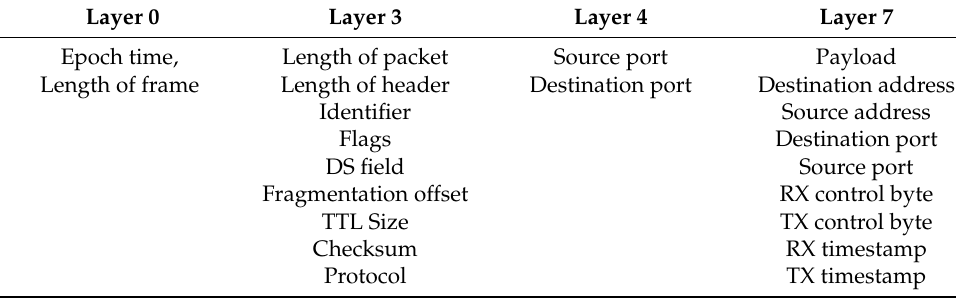
Table 2. Input data taken from captured packets from the specific